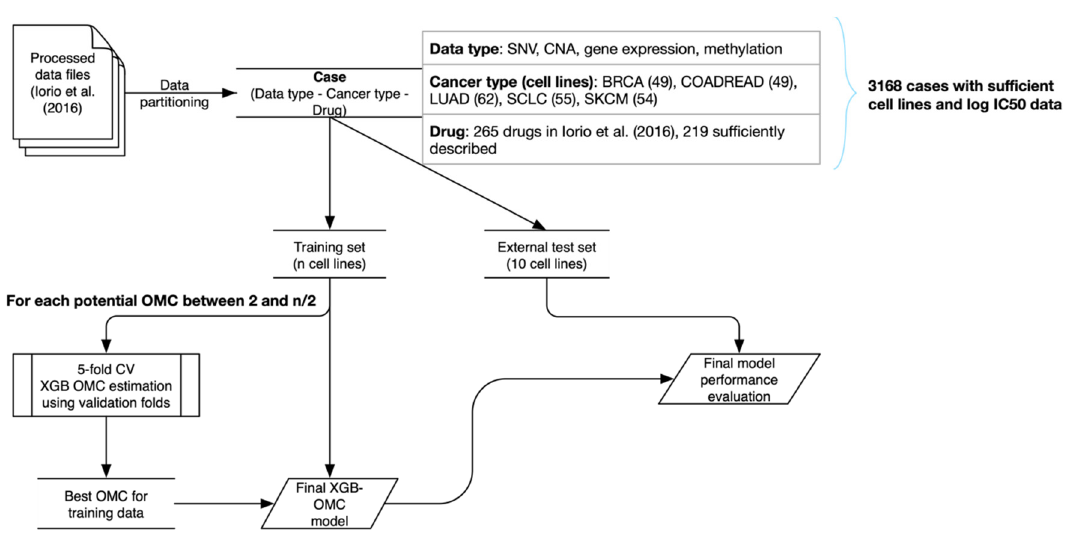
Figure 1. Schematic outline of the procedure to determine the Optimal Model Complexity (OMC) for each case and evaluating the resulting models. Data pre-processed in the latest Genomics of Drug Sensitivity in Cancer (GDSC) study [5] is partitioned into unique cases and then split into training and test sets. A five-fold cross-validation using stratified folds is used to establish which are the top k features (where k takes all the integer values between 2 and n / 2, with n being the number of training cell lines), leading to the most predictive XGB regression model over the five cross-validation runs. Once the optimal k (k_opt) has been determined, the top k_opt features on the entire training set are identified. This is repeated for each case, giving rise to the predictive models discovered and analyzed in this study.